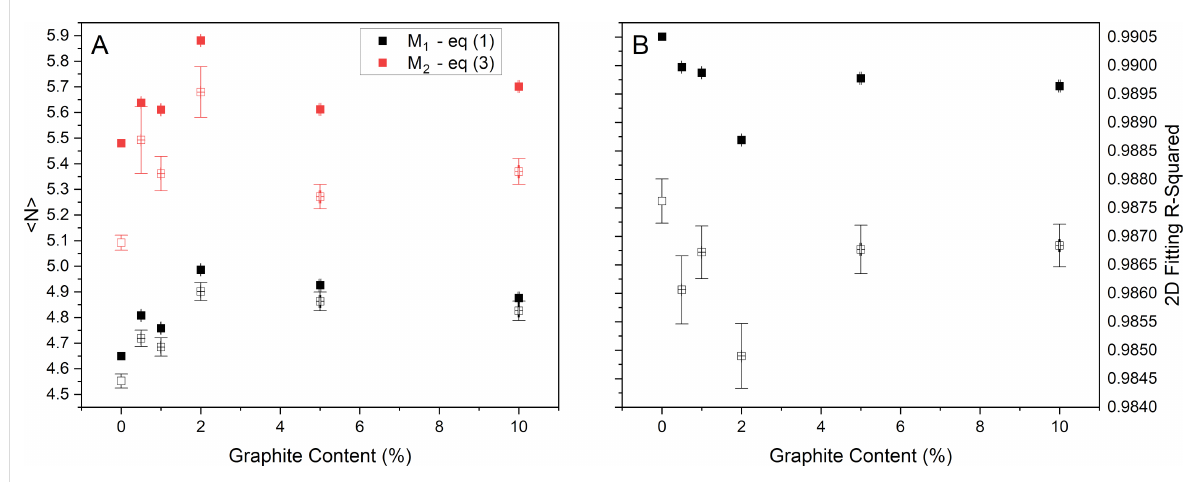
Figure 5: Comparison of literature metrics applied to the current data. (A) Mean number of layers calculated for the two metrics published by Backes and co-workers [13]. (B) R 2 value for fitting the 2D peak, as proposed by Roscher and co-workers [23]. In both cases, results are shown from analy- sis of both averaged spectra (filled markers) and individual spectra within each map (open markers). In the latter case, the median value is shown with the error bars showing the standard